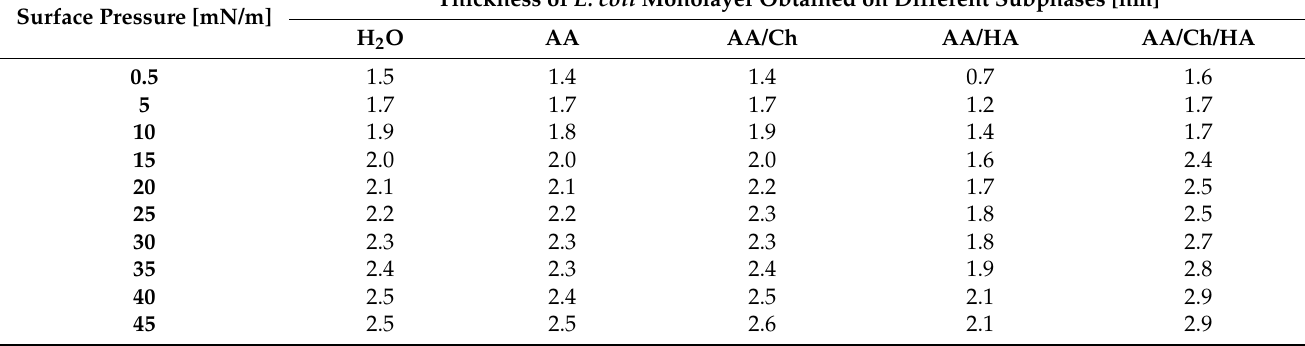
Table 4. Thickness of the E. coli lipid monolayers during